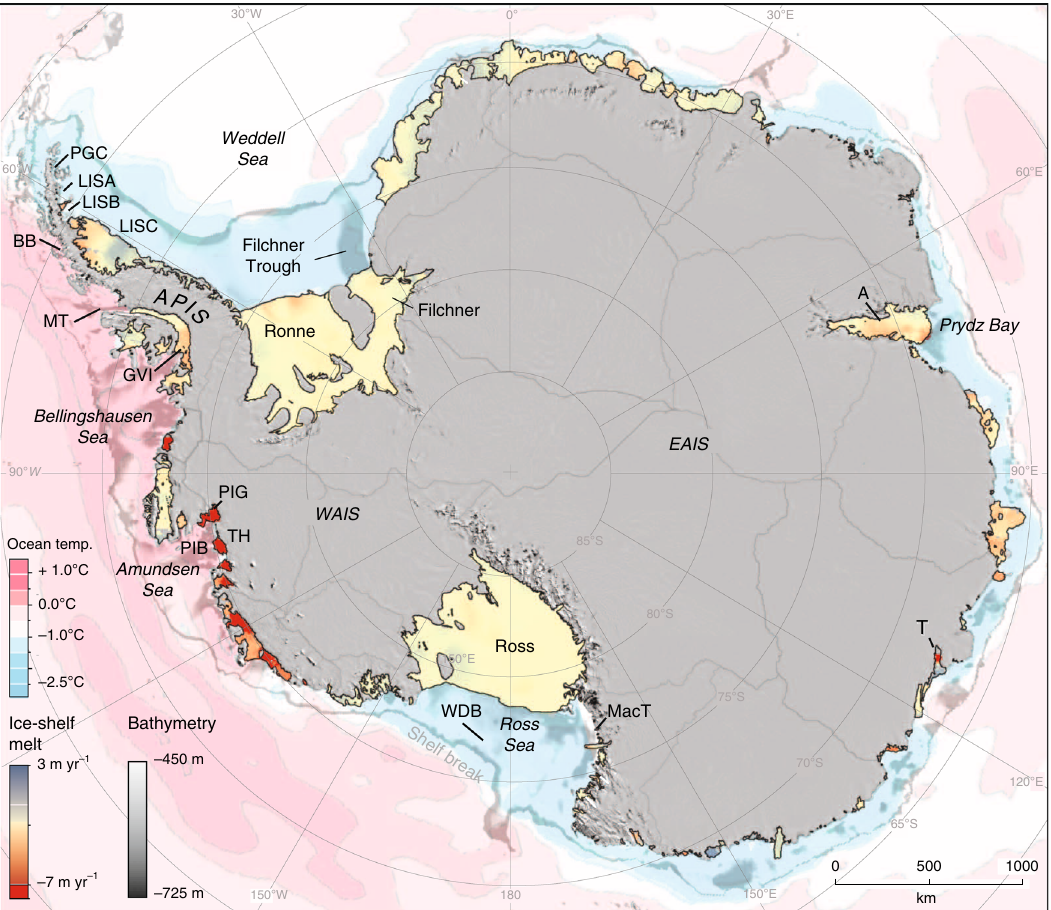
Fig. 1 Rate of change of Antarctic ice-shelf and ice-sheet thickness 1 . Estimated average sea fl oor potential temperatures (in °C) from the World Ocean Circulation Experiment Southern Ocean Atlas 145 (pink to blue) are overlaid on continental shelf bathymetry (in metres) 146 (greyscale, landward of the continental-shelf break). APIS Antarctic Peninsula Ice Sheet, WAIS and EAIS West and East Antarctic Ice Sheets, PGC Prince Gustav Channel, LISA Larsen A, LISB Larsen B, LISC Larsen C, BB Barilari Bay, MT Marguerite Trough, GVI George VI Ice Shelf, PIG/PIB Pine Island Glacier/Bay, TH Thwaites, MacT Mackay Glacier Tongue, WDB Whales Deep Basin,T Totten, A